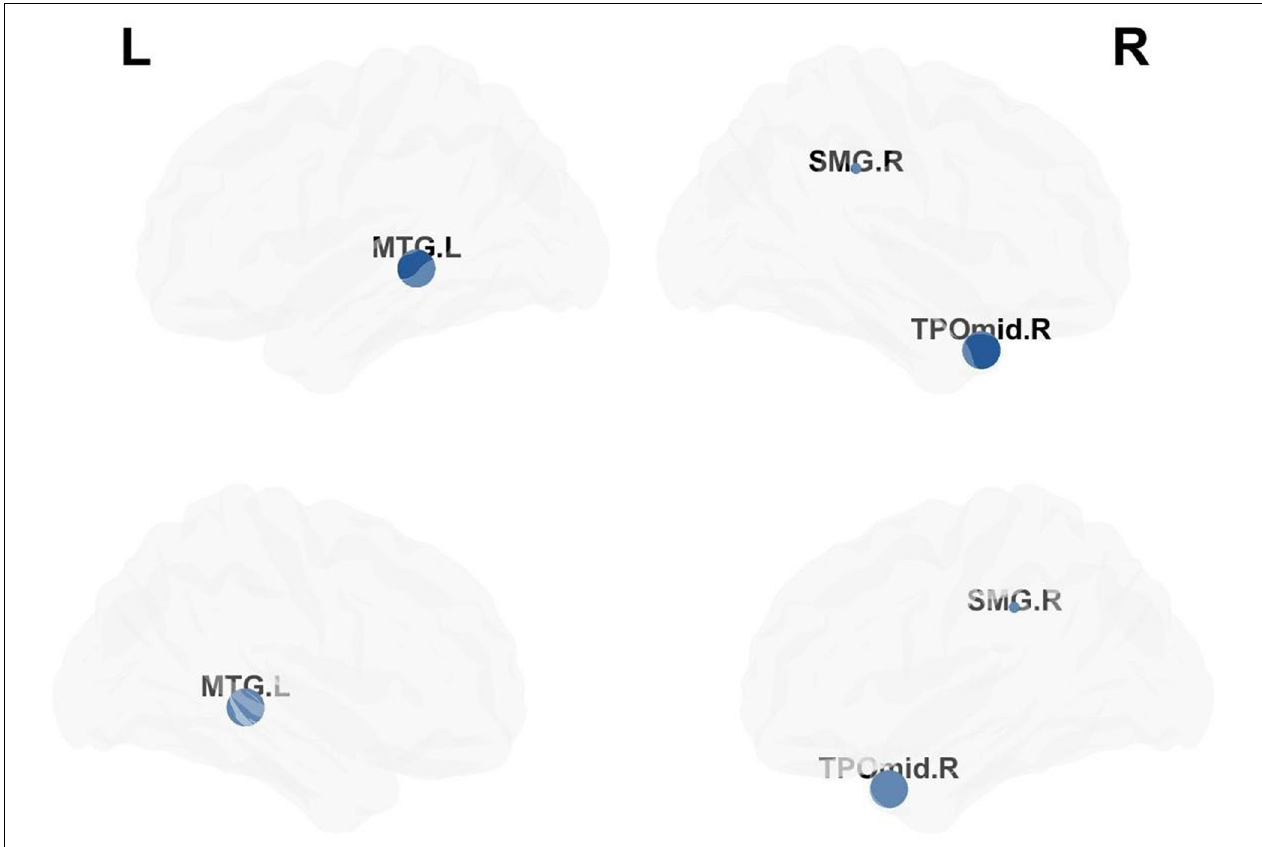
FIGURE 5 | Analysis of nodal properties. The regional distribution with differences in the Betweenness Centrality, Degree Centrality and Nodal Efficiency drawn by the BrainNet Viewer toolbox. TABLE 4 | Attribute changes of the